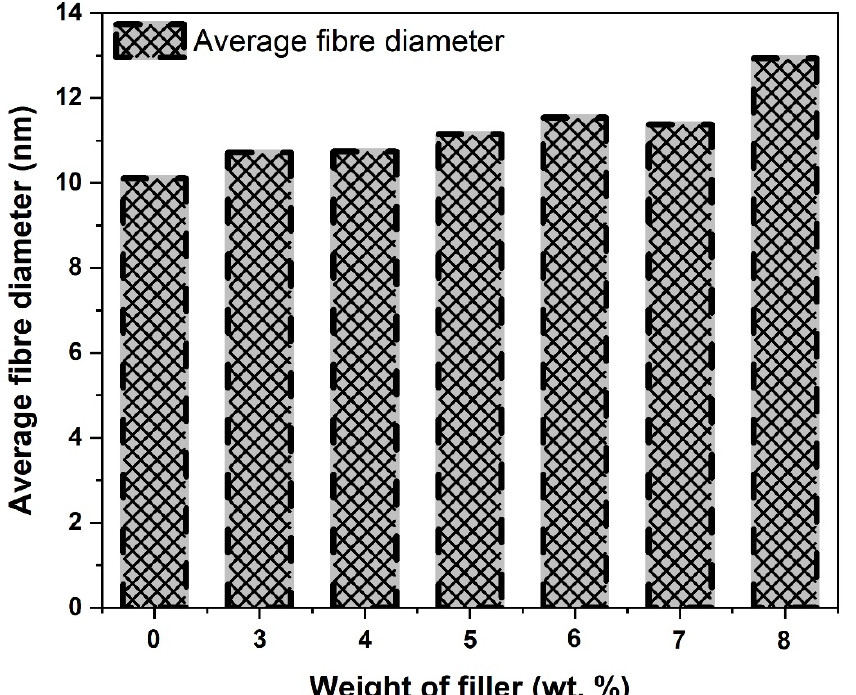
Figure 12. Average fibre diameter of CCP-PLA nanofibres.